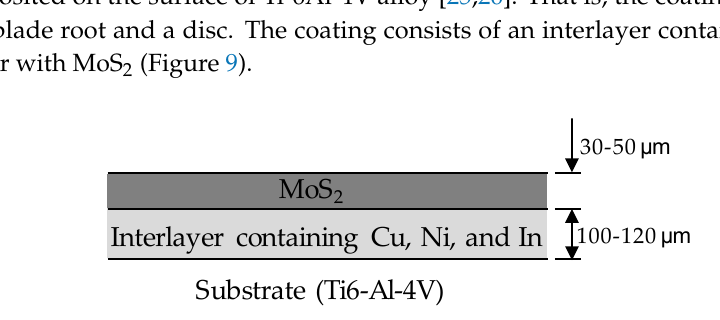
Table 2. Example of anti-fretting coatings.